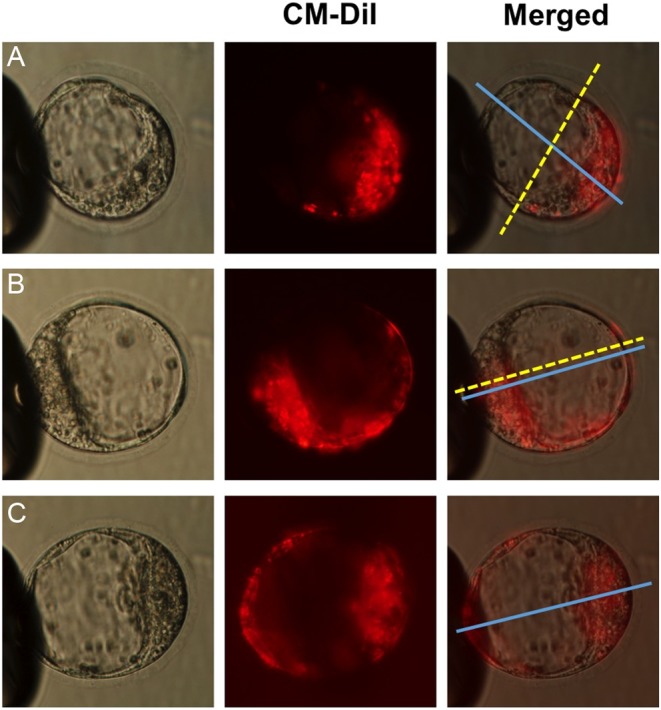
Mouse embryo cell allocation patterns at blastocyst stage. (A) Orthogonal embryos, the boundary (doted yellow line) of the stained and non-stained cells is orthogonal to the embryonic-abembryonic (Em-Ab) axis (blue line); (B) Deviant embryos, the boundary of stained and non-stained cells is parallel to the Em-Ab axis; and (C) Random embryos, stained and non-stained cells are randomly distributed and no boundary line between them can be seen.